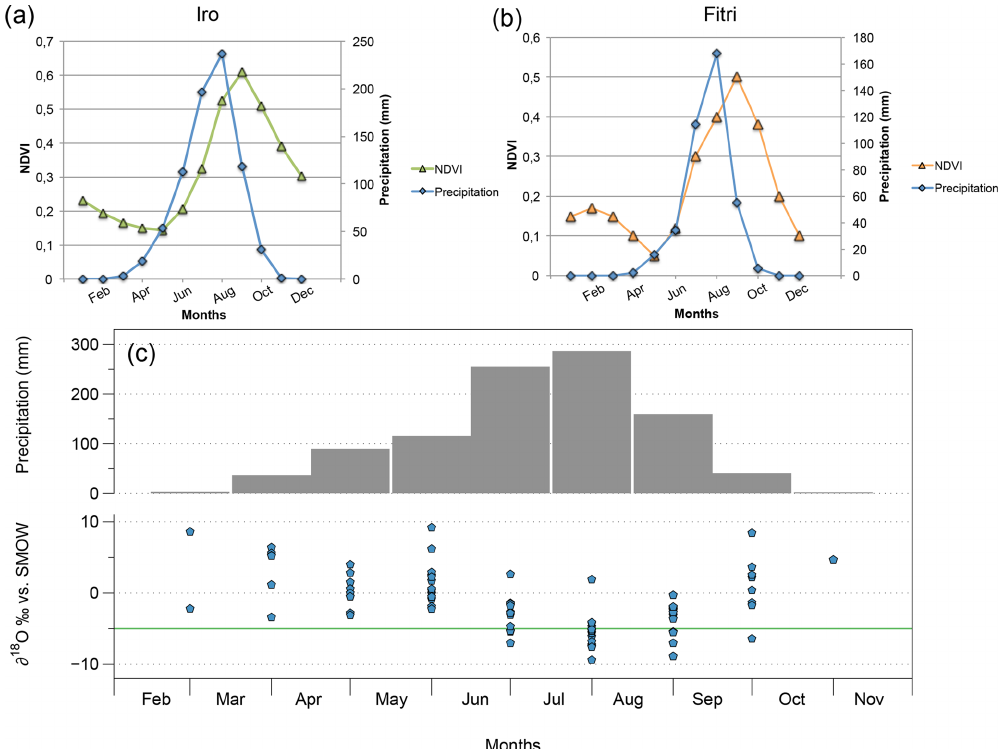
Figure 9. (a) and (b) represent the monthly average precipitation (blue) over a year at the Am Timan and Ati station for Iro Lake and Lake Fitri, respectively. Green and orange symbols represent the NDVI (normalized difference vegetation index) evolution over a year. For both catchments, a 1-month delay between the maximum precipitation and the maximum NDVI is observed. (c) The grey bars represent the monthly average precipitation. The blue dots represent the precipitation isotopic signature evolution ( δ 18 O) month by month and the green line is δ I (taken at the intersection between GMWL and LEL). The maximum of precipitation corresponds to a depleted isotopic signature (Dansgaard